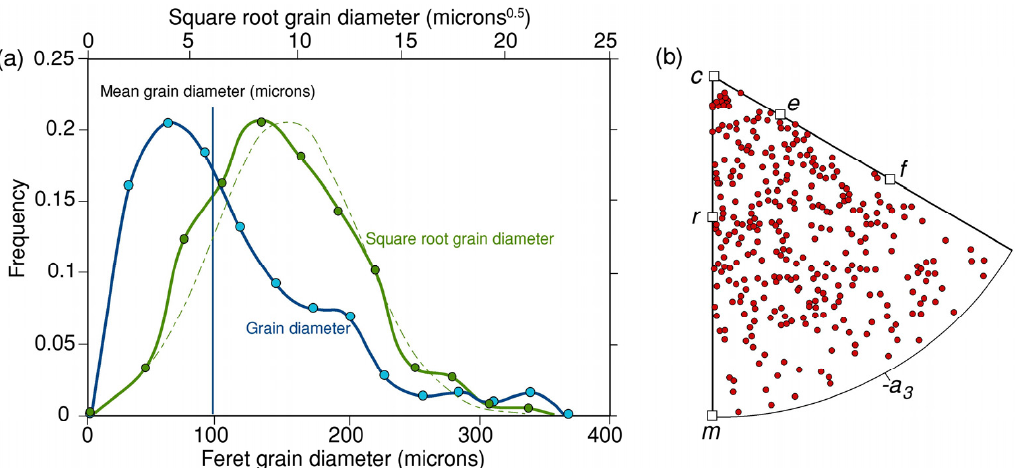
Figure 2. ( a ) Frequency distribution of the 320 Feret grain diameters in the sample of Carrara marble, with frequency plotted against grain diameter in blue, and against square root grain diameter in green. The green dashed line is a Gaussian curve for comparison, with the same mean and standard deviation as the square root grain size plot. The arithmetic mean grain diameter (99 μ m) is indicated; ( b ) Inverse pole figure of calcite (upper hemisphere equal angle projection) showing the orientations of all 320 measured grains with respect to the specimen axis.